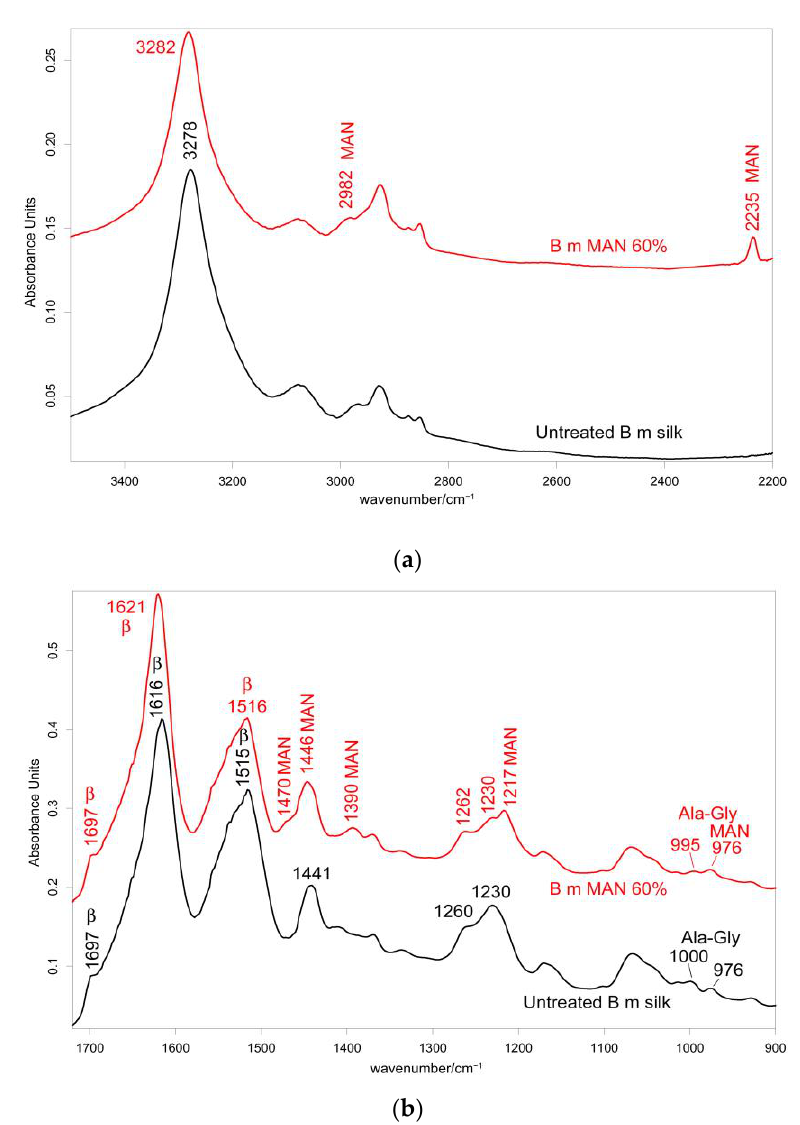
Figure 2. IR spectra recorded in the parallel orientation on B. mori silk fibroin fibers before and after grafting with MAN at the highest weight gain (i.e., 60%) in the 3500 – 2200 cm −1 ( a ) and 1720 – 900 cm − 1 ( b ) spectral ranges. The spectra are normalized to the intensity of the Amide I band (1616 – 1621 cm − 1 ). The main bands assigned to β -sheet ( β ) conformation, as well as to alanine-glycine domains (Ala-Gly), are indicated together with those having a contribution from